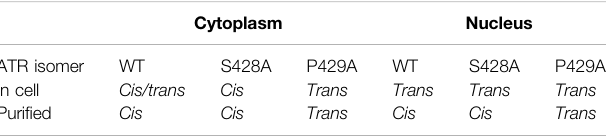
TABLE 1 | Identi fi ed conformational variations of ART WT, S428A, and P429A in cells or after isolation via FLAG-tagged immunoaf fi nity puri fi cation and a high salt